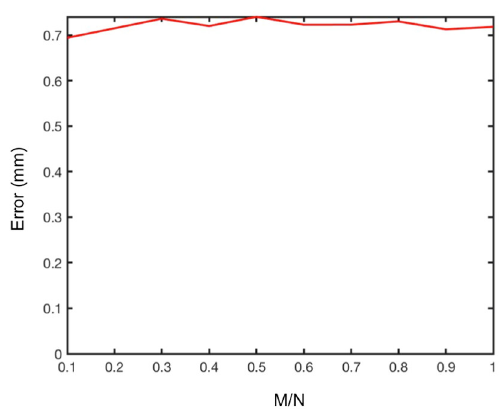
Figure 21. Displacement error in function of M / N for a stable point in the open pit mine.